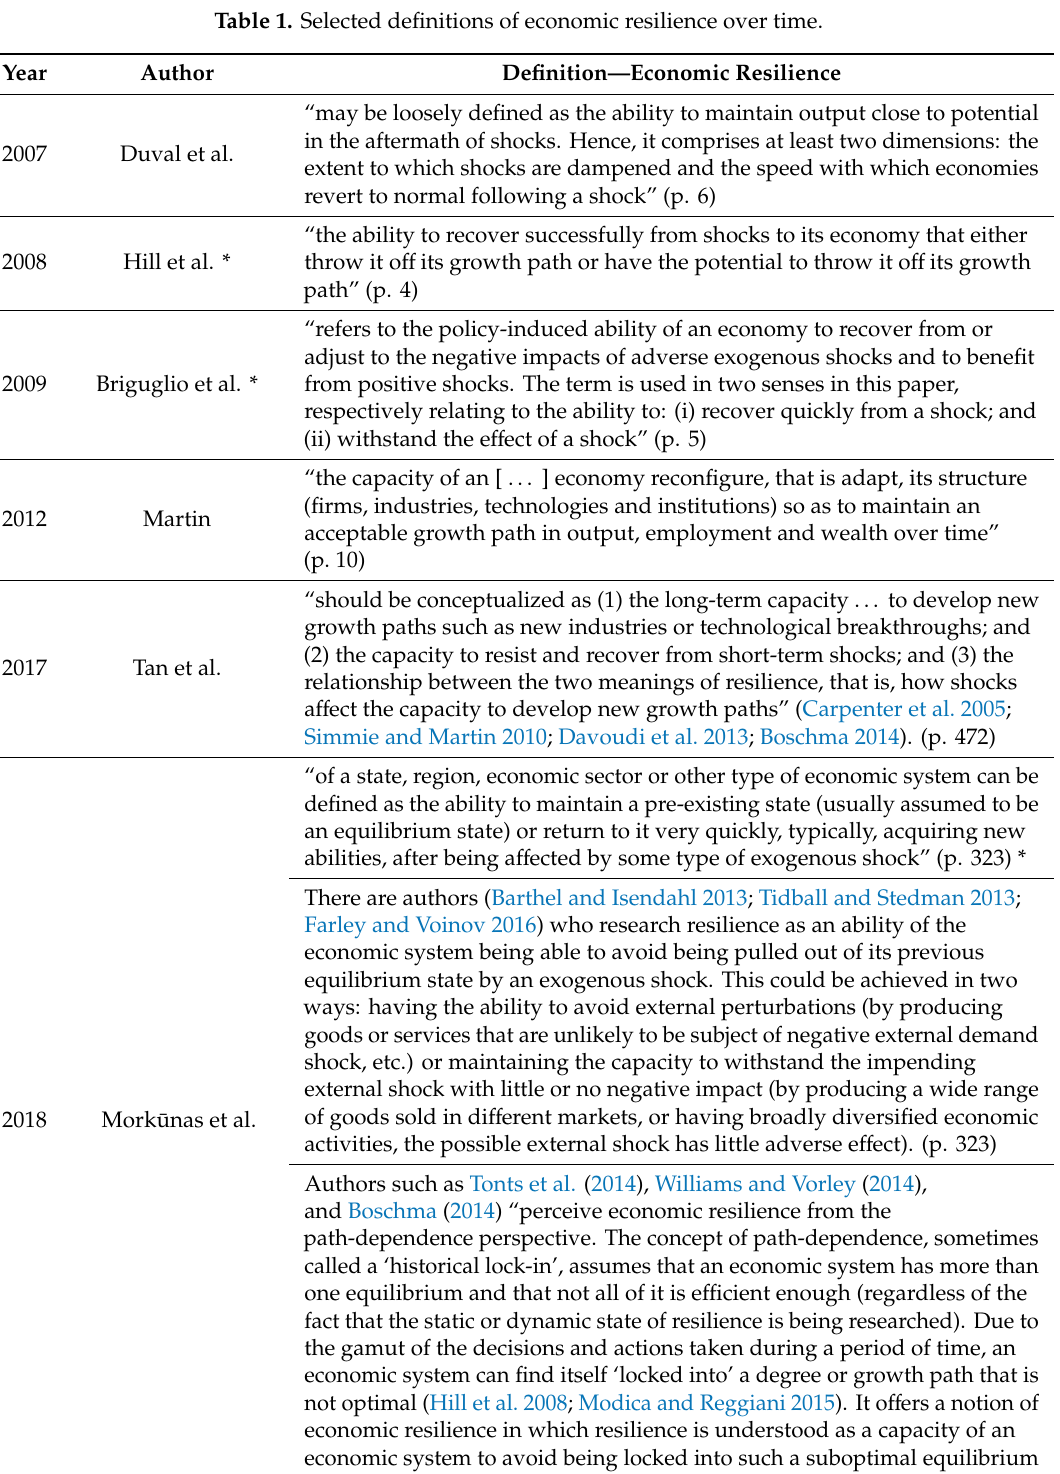
Table 1. Selected definitions of economic resilience over